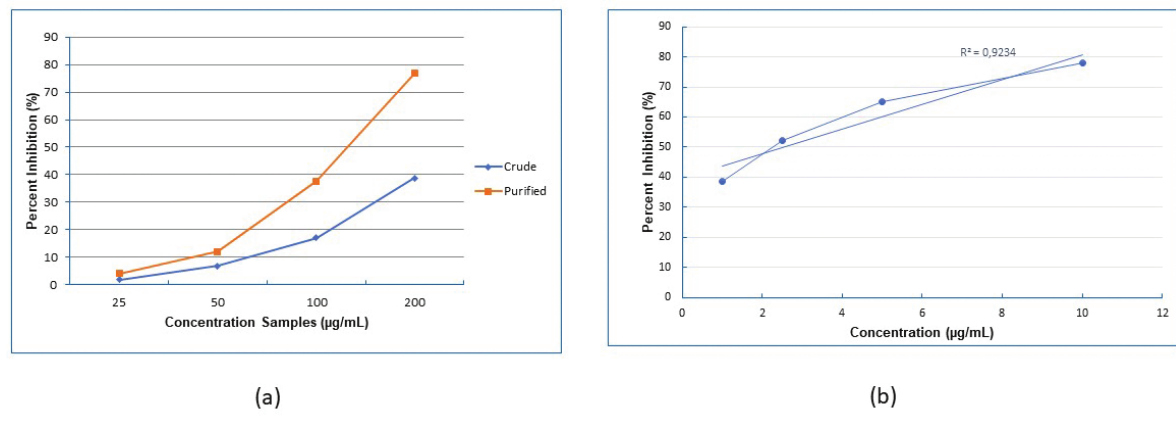
Figure 6. Analysis of the antidiabetic activity of (a) sulfate polysaccharides from C. lentillifera (b)